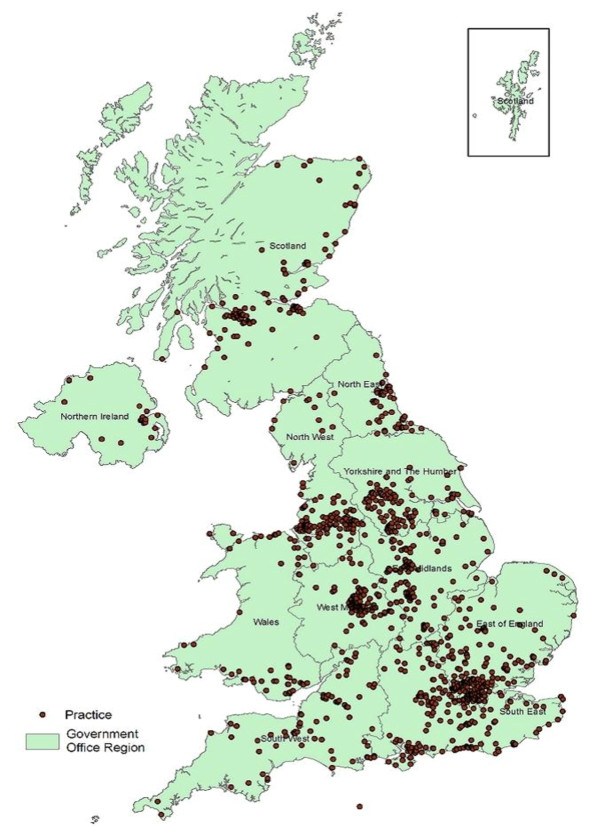
UK distribution of study practices.